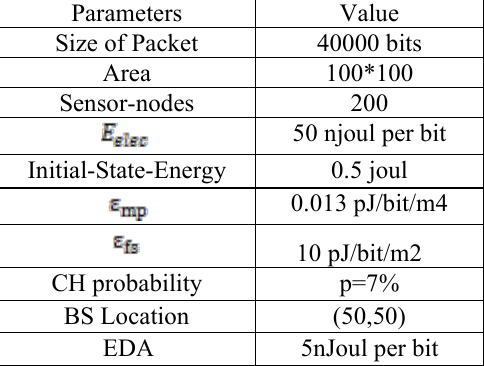
Figure 3. LEATCH protocol Process